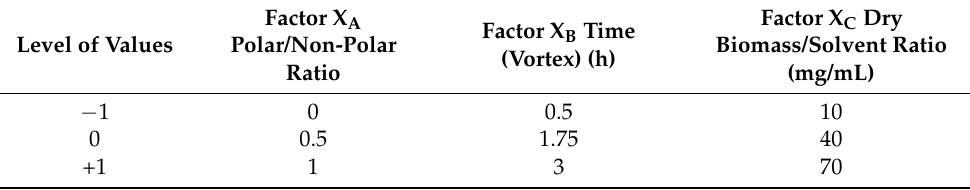
Table 2. Level of values of the independent variables of the statistical design